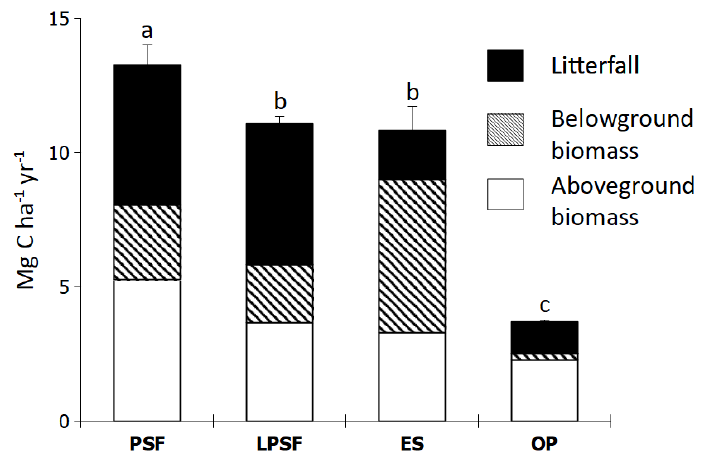
Figure 4. Primary production of belowground biomass, aboveground biomass and litterfall (NPP) in intact and logged peat forest, early seral sites (ES), and oil palm estates (OP). Production of biomass and litterfall (NPP) reported as a mean value. Error bars show ± standard error (SE) of the production. PSF represents intact peat forests, and LPSF means partially logged forests. Lower case letters represent statistical significance in production. Adapted by permission from [Springer